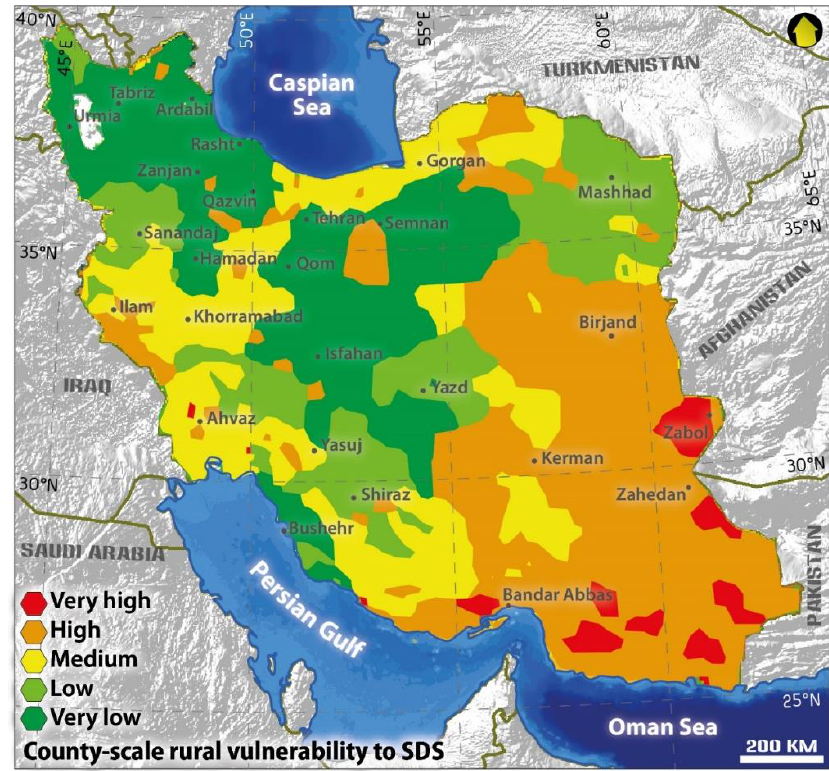
Figure 5. Iran ’s rural vulnerability to sand and dust storms. Figure 5. Iran’s rural vulnerability to sand and dust storms.